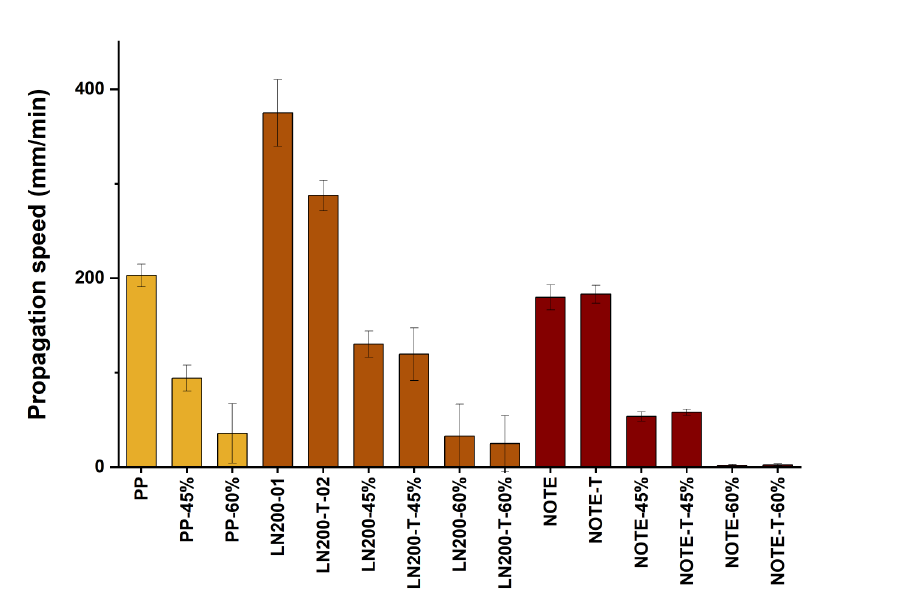
Figure 10: Propagation speed of composites with additive.